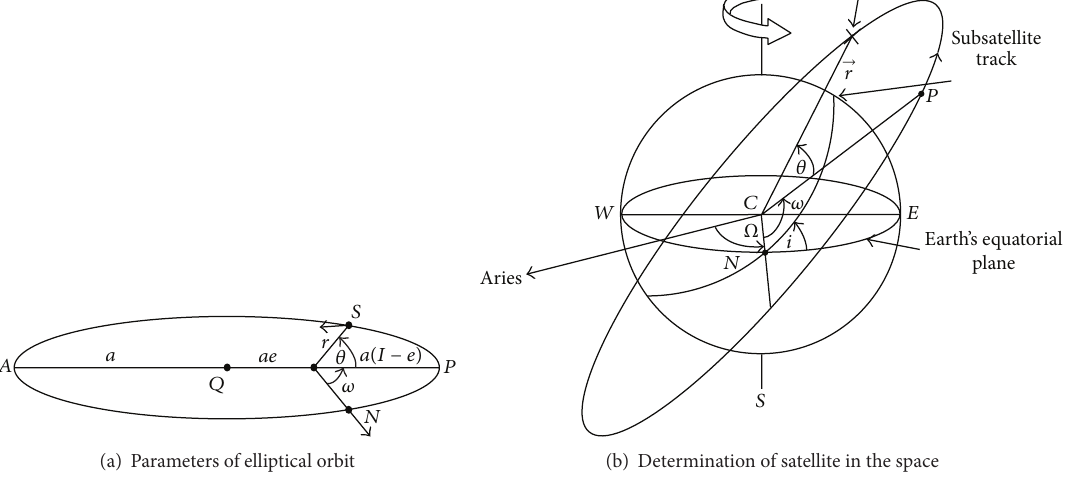
Figure 1: Elliptical orbit